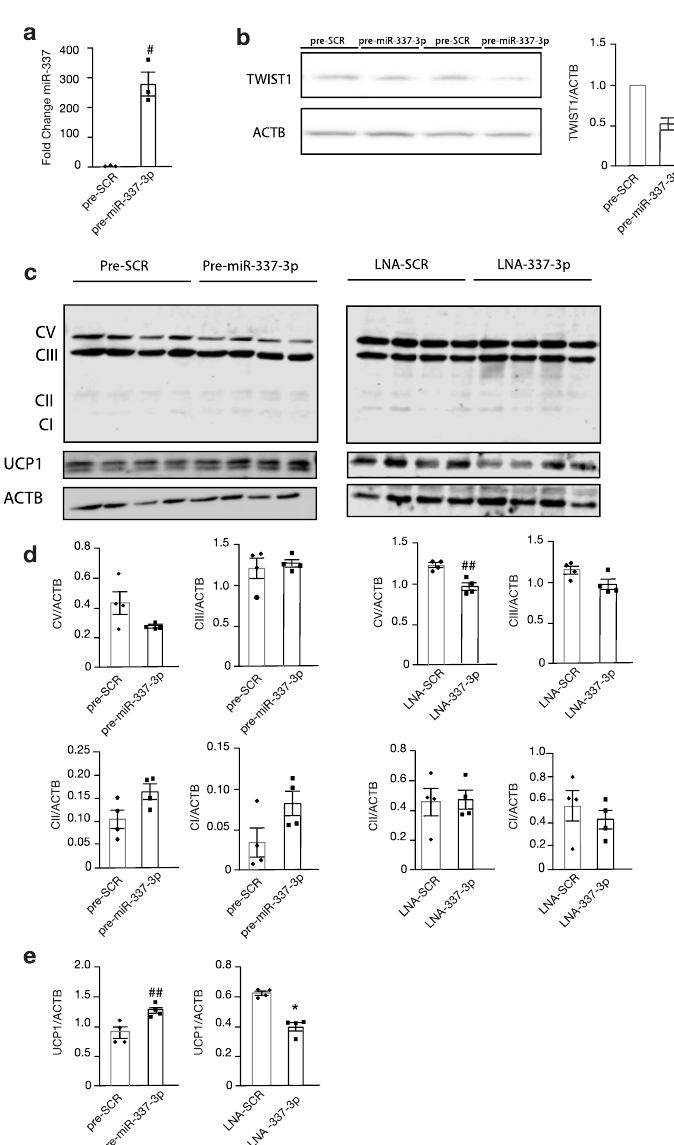
Figure 4. Modulation of miR-337-3p influences Twist1 and downstream thermogenic proteins. ( a ) RT-PCR analysis of mmu-miR-337-3p in murine brown adipocytes transfected with either precursor mmu-miR-337-3p or precursor scrambled molecule. ( b ) Western blot analysis of Twist-1 protein abundance of precursor mmu-miR-337-3p or precursor-scrambled transfected brown adipocytes and its quantification on the right (n = 2). ( c ) Western blot analysis of OXPHOS, Complex V-I, UCP1, and ACTB in brown adipocytes transfected with (left panel) either precursor mmu-miR-337-3p or precursor scrambled, or (right panel) transfected with LNA mmu-miR-337-3p inhibitor or scrambled inhibitor (n = 4 per group). ( d ) Quantification of OXPHOS Complex V-I protein abundance from ( c ) Western blot ( e ) Quantification of UCP1 protein abundance from ( c ) Western blot. Data are presented as means ± SEM, and individual data points are given by the dot plot. # p < 0.05, Independent sample t -test, equal variances not assumed * p < 0.05 Mann–Whitney-U for independent samples. ## p < 0.01, Independent sample t -test with equality of variances. n, number of biological replicas; OXPHOS, oxidative phosphorylation; UCP1, uncoupling protein 1; ACTB, beta-actin RT-PCR, quantitative real-time polymerase chain